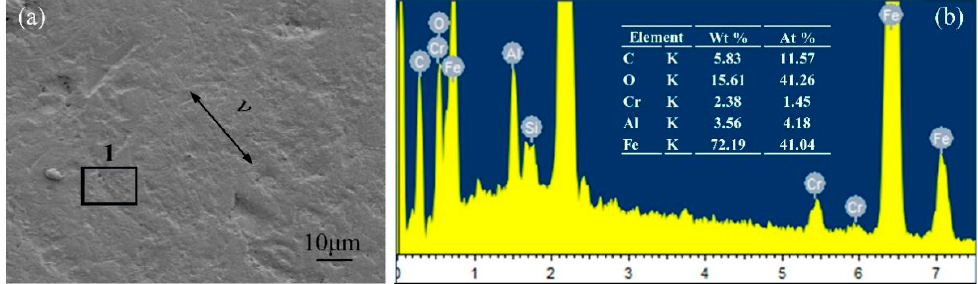
Figure 12. SEM images and EDS analysis of GCr15 metal surface after wear of untextured samples: ( a ) SEM image of untextured sample surface; ( b ) corresponding EDS analysis.